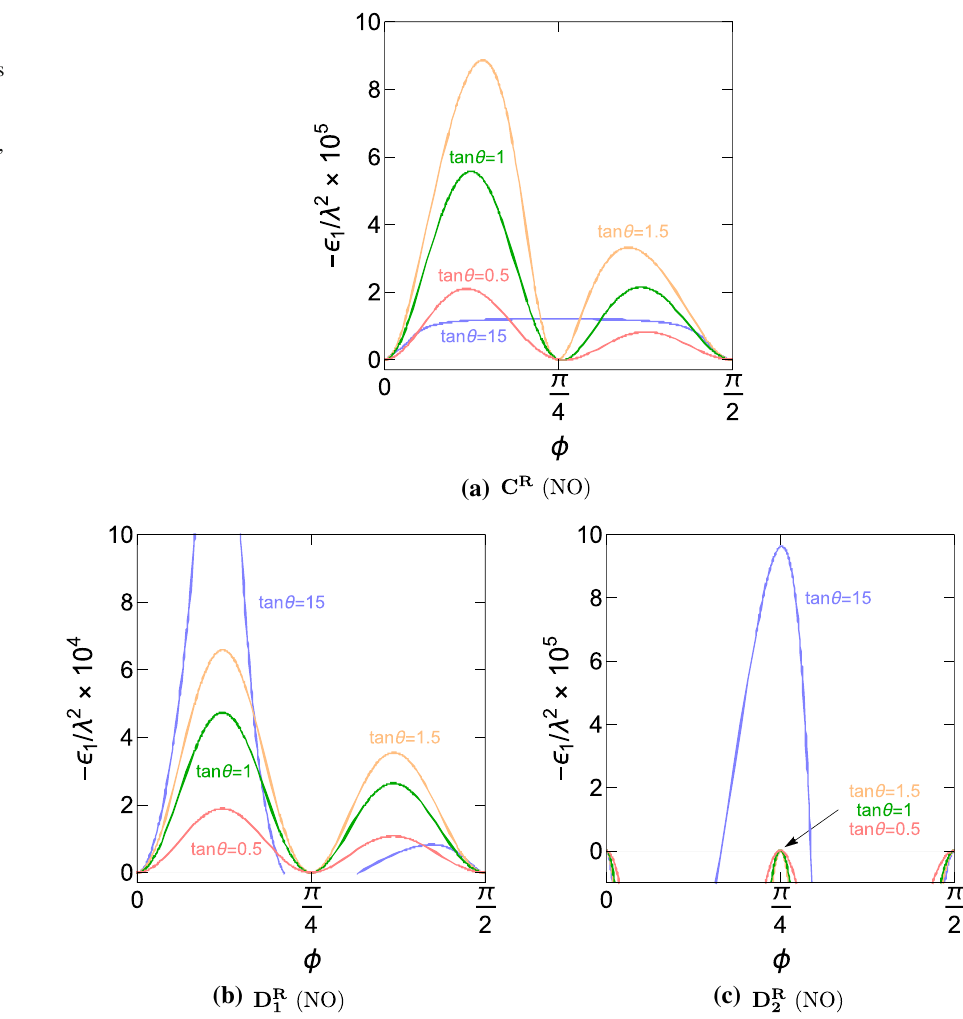
predict the NO or the IO if θ 23 is taken to be in the range of 3 σ , and in that of mass, there is a strong tension between the prediction and the Planck limit. Moreover, in that of leptogenesis, it means that the limited parameter regions realize the correct sign and enough size of the baryon asymmetry. “ (cid:5) ” means that the models predict that the 0 νββ process